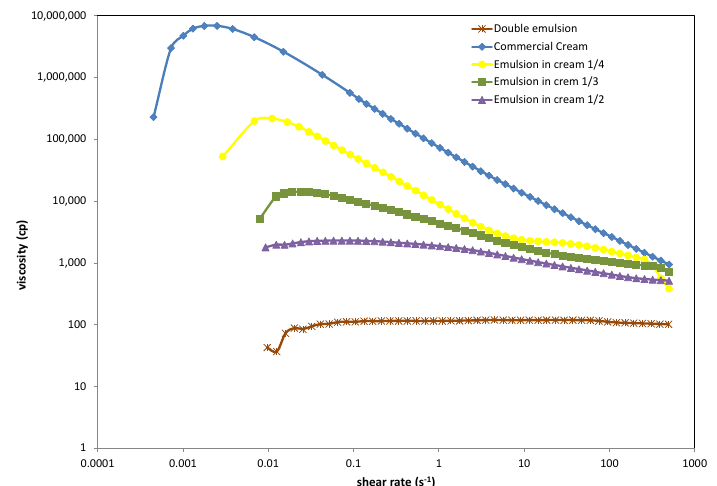
Figure 4. Viscosity measurements of the commercial cream and mixtures of the commercial cream with the double emulsion W 1 /O/W 2 of concentration 80/20 with an internal phase ratio W 1 /O of 30/70.